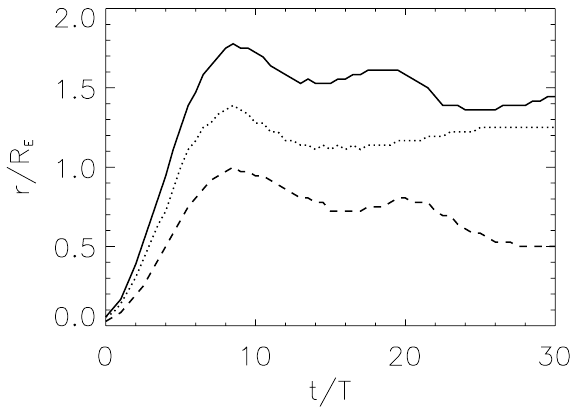
Fig. 10. Magnetopause boundary oscillations corresponding to Fig. 9. See Fig. 8 for definition of the position